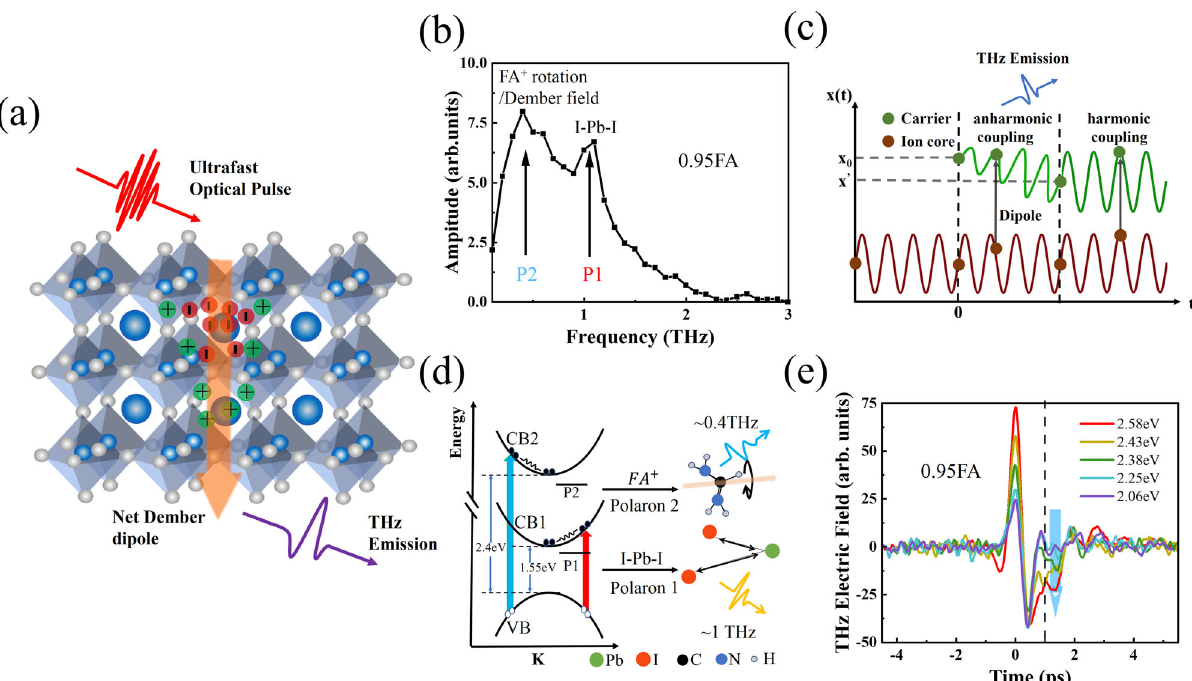
Fig. 2 | The polaron emission mechanism in FAPbI 3 . a Schematic illustration of the THz emission from the photo-Dember effect. b Amplitude spectrum of the emitted THz fi eld form 0.95FA exhibiting two distinct peaks at ~0.4 and ~1THz, excited by 2.58eV pump photon energy; c Schematic of THz emission resulting frompolaronformation,X 0 andX ′ arethedistanceofthecarrierwithrespecttothe ion, the coupling between carrier and ionic lattice goes through two stages: